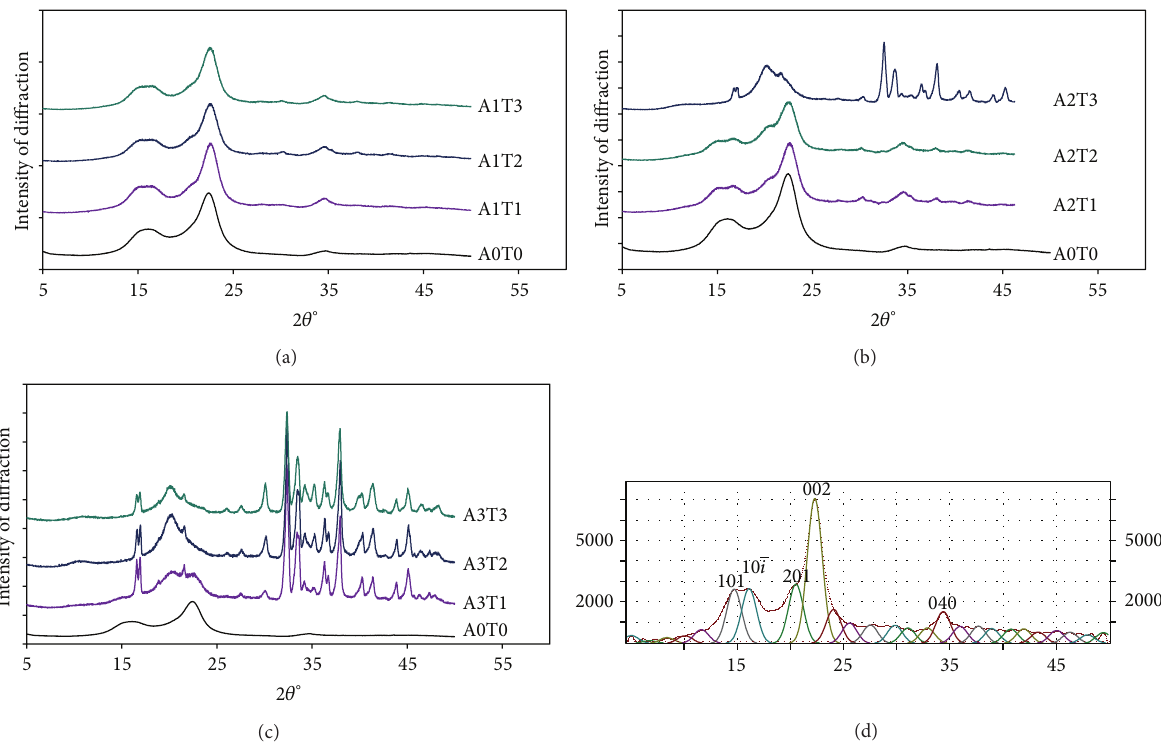
Figure 1: Diffractograms of untreated cellulose and of samples alkalized with different NaOH concentrations and times. (a) NaOH 10%. (b) NaOH 20%. (c) NaOH 30%. (d) A1T1 after